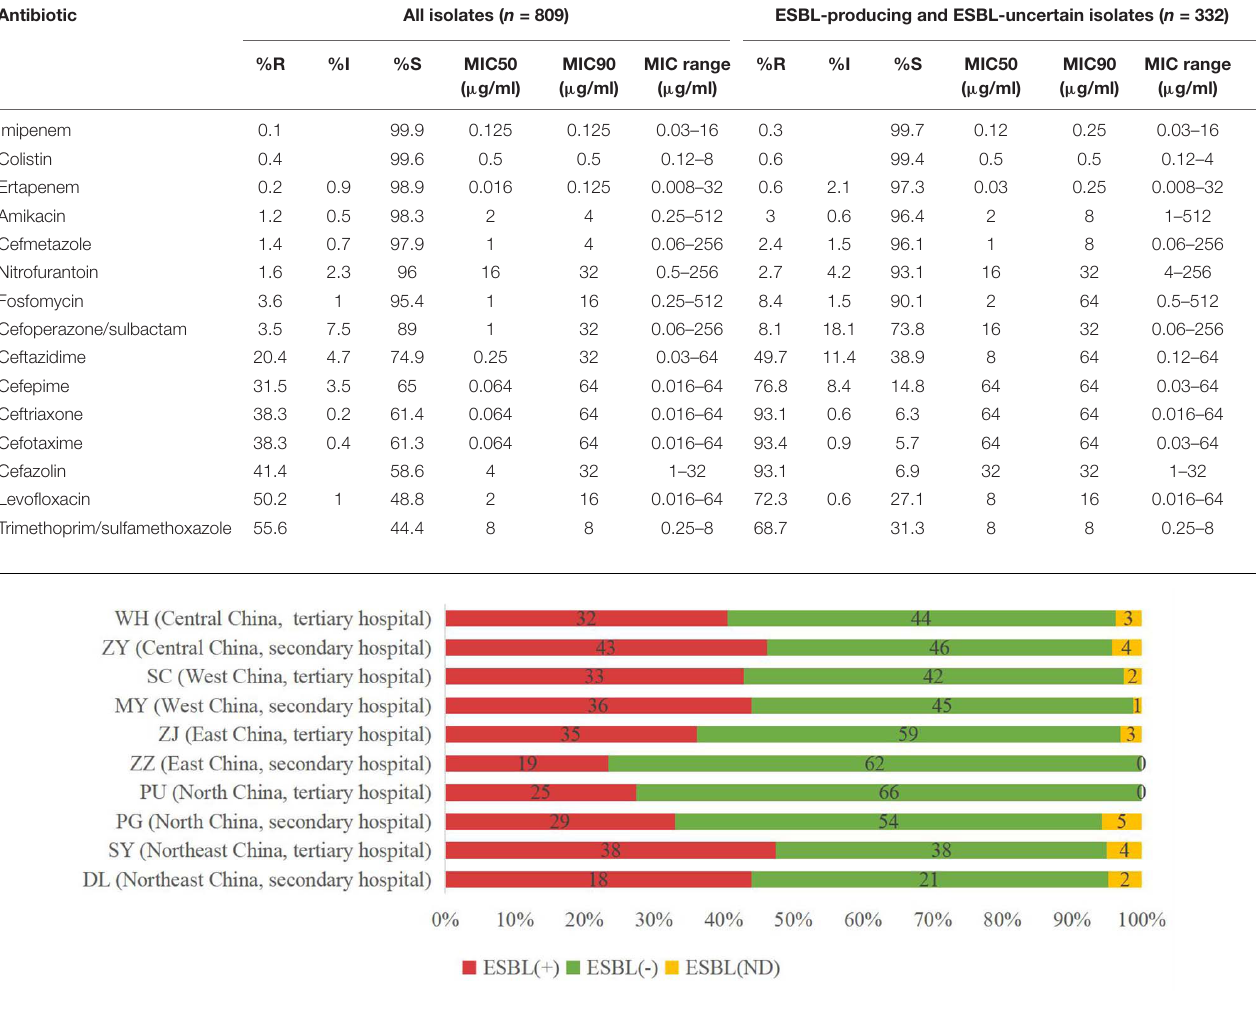
FIGURE 2 | Incidence of extended-spectrum beta-lactamase (ESBL)-producing strains in different sites of China. ESBL (+), ESBL-positive isolates; ESBL ( − ), ESBL-negative isolates; and ESBL (ND), ESBL-uncertain